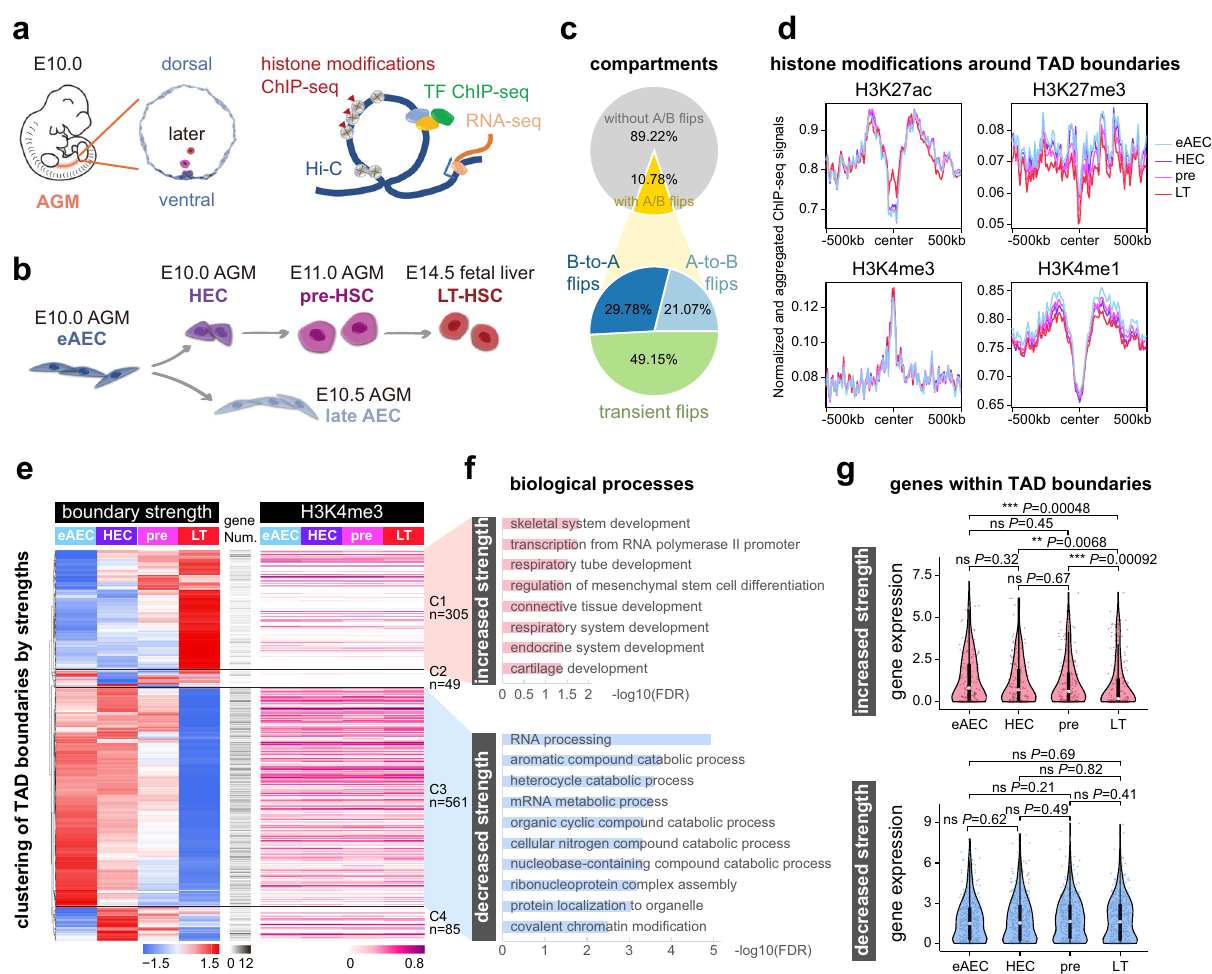
Fig. 1 Annotating the large-scale 3D genome re-organization with chromatin states during HSC formation. a Schematic of experimental design for multi- omics pro fi ling across four populations. b The sampling scheme. Surface markers were provided in the methods. c Pie charts for the ratio of A/B compartment fl ips. B-to-A fl ips indicate a resulting compartment B to A change during differentiation, and A-to-B fl ips likewise indicate A to B; Transient fl ips indicate the change involving both A to B and B to A along the differentiation path. d Aggregate curves showing features of different histone modi fi cation ChIP signals around TAD boundary regions. The values were calculated with signals on ChIP-seq peaks. Each region was ±500 kb around TAD boundary centers, with 10 kb bin size. e Heatmap showing the clustering of top 1000 variable TAD boundaries (40 kb bin) by boundary strengths (row- scaled), and the corresponding H3K4me3 signals at TAD boundaries. Each row was one TAD boundary, identi fi ed by insulation scores. The minus value of the insulation score was boundary strength. The numbers of genes within each TAD boundary were shown. The ANOVA P -value (one-side) of H3K4me3 signals at TAD boundaries with increased strength among four stages was 0.922. The ANOVA P -value (one-side) of H3K4me3 signals at TAD boundaries with decreased strength among four stages was 0.353. f Gene ontology analysis for biological processes of TAD boundary clusters. The GO analysis was done by GREAT. P -value was calculated by two-sided binomial test and adjusted by Benjamini – Hochberg (BH) correction (FDR). The X- axis was − log10(FDR) of each term. g Violin plots of gene expression as in ( f ). Gene expression values were calculated and normalized with log2(TPM/10 + 1) from previous scRNA-seq data (GSE139389 and GSE67120). Each dot represented one single cell. In boundaries with increased strength, n = 166 genes. In boundaries with decreased strength, n = 429 genes. Box-and-whiskers plots represented the maxima, 75th percentile, median, 25th percentile, and minima. Pairwise comparisons between any two populations were performed through two-sample Wilcoxon Rank Sum test (two-side). * P -value < 0.05; ** P -value < 0.01; *** P -value < 0.001; **** P -value < 0.0001; “ ns ” not signi fi cant. eAEC early AEC, pre pre-HSC, LT LT-HSC. H3K4me3-positive genes. Cluster 3 (C3) boundaries with decreased strengths were mainly linked to cellular catabolic processes and associated with more H3K4me3-positive genes (Fig. 1f). However, H3K4me3 enrichment levels at TAD boundaries were statistically stable across stages (Fig. 1e). Next, we clustered all identi fi ed TAD boundaries across four-cell populations and calculated associated H3K4me3 signals, further supporting the above fi nding (Supplementary Fig. 1f). These lines of evidence suggested that the TAD boundary strength might play a role implicated in HSC dormancy, as also reported elsewhere 42 . However, the genes on boundary clusters C1 and C3 did not NATURE COMMUNICATIONS| (2022) 13:346